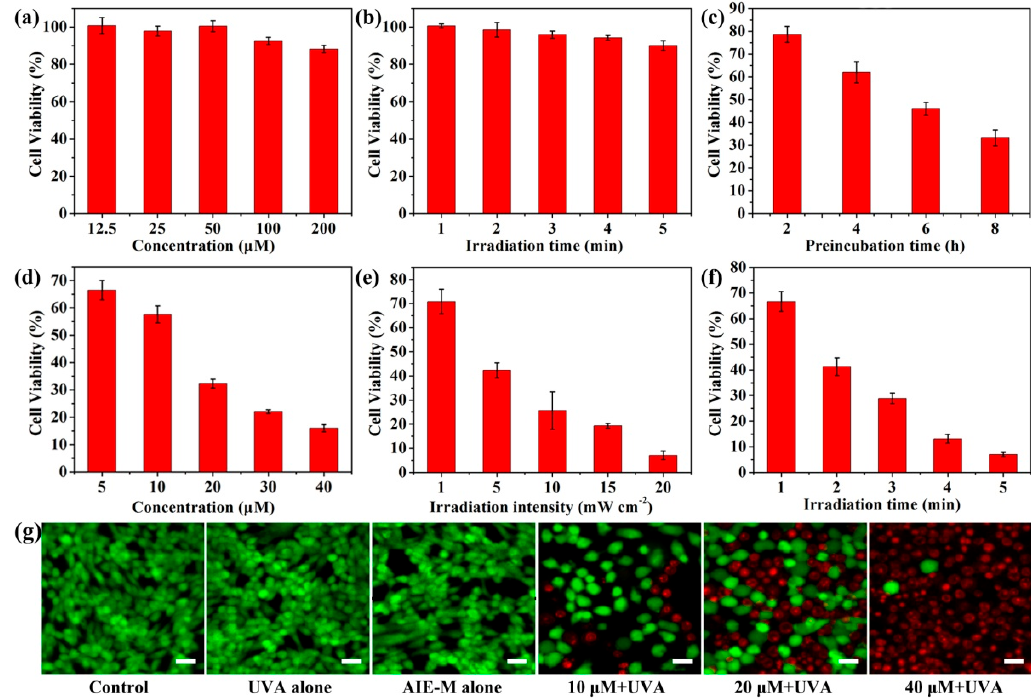
Figure 9. Viability of HeLa cells treated with AIE-M at variable concentrations for 48 h without light irradiation ( a ), light irradiation only (10 mW cm − 2 ) for different irradiation times ( b ), AIE-M (20 μ M) for different preincubation time and light irradiation (1.5 J cm − 2 ) ( c ), AIE-M at different concentrations (5–40 μ M) for 8 h and light irradiation (1.5 J cm − 2 ) ( d ), AIE-M (20 μ M) for 8 h and different power of light irradiation (1–20 mW cm − 2 ) ( e ), AIE-M (20 μ M) for 8 h and different light irradiation